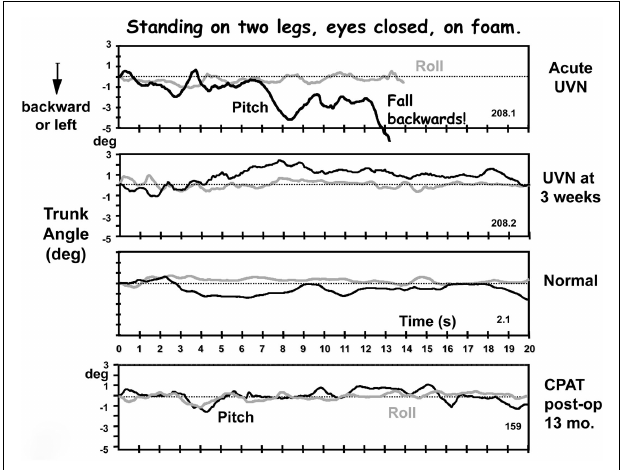
FIGURE 2 | Original traces of pitch and roll movements of the lower back (L1-3) recorded from a patient with an acute peripheral unilateral vestibular neuritis (UVN) while standing eyes closed on a foam surface. The upper traces were recorded in the acute phase (within 5days of loss onset), the middle traces 3weeks later.These traces can be compared with those labeled “normal” of a healthy subject of the same age and gender and with those of a CPAT patient 13months post-operatively. Note the near fall backward after 8s until a final loss of balance control at 13s in the upper traces.The recording duration of the other traces lasted the full 20s of the trial. Data from Allum and Adkin (2003), Beule and Allum